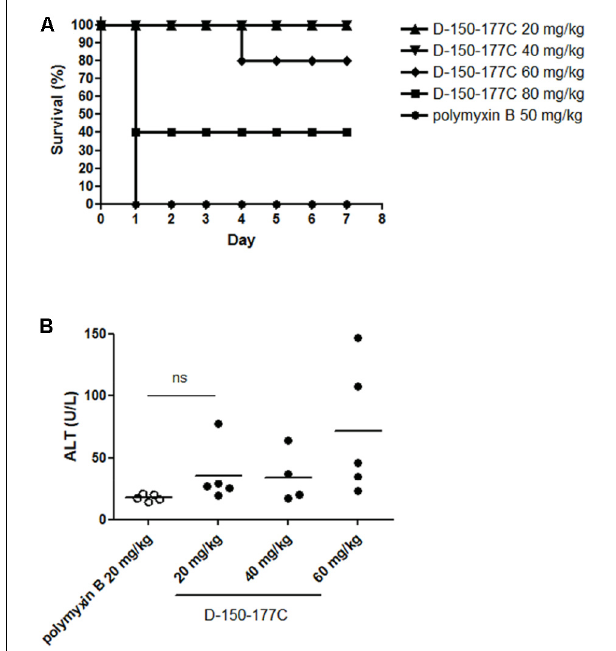
FIGURE 3 | In vivo toxicity of D-150-177C peptide. At day 0, male ICR mice (5 mice/group) were i.p. injected with different doses of D-150-177C peptide (20–80 mg/kg) and polymyxin B (50 mg/kg), respectively. (A) The survival rates of all groups were monitored for 7 days. All mice treated with polymyxin B (50 mg/kg) died at day 1. In contrast, no acute toxicity was observed in mice treated with 20 and 40 mg/kg D-150-177C. When we increased the dose to 60 and 80 mg/kg, the survival rates of mice were decreased to 80 and 40%. (B) Alanine aminotransferase activity (ALT) was measured in serum samples of mice treated with D-150-177C or polymyxin B at day 1. The horizontal bars represent the means of ALT values of ICR mice in different experimental groups. Treatment with D-150-177C in the dose of 20 and 40 mg/kg showed a slight increase in the ALT level than treatment with polymyxin B at 20 mg/kg. The ALT level of mice treated with 60 mg/kg D-150-177C was significantly higher than that treated with polymyxin B at 20 mg/kg ( P <